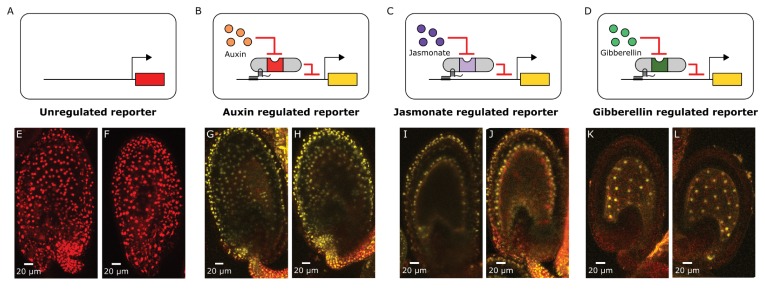
Distributions of auxin, gibberellin and jasmonate during early embryo development can be mapped out using HACRs.(A–D) These schematics depict the HACR circuits in the plant lines whose ovules have been imaged using confocal microscopy directly below them. (E–L) Confocal microscopy images of ovules from these reporter lines 48 hr post pollination visualizing either the tdTomato (in the case of the unregulated reporter) reporter signal or the Venus (in the case of the HACR lines) reporter signal. We observe ubiquitous reporter signal in the unregulated reporter (E,F) confirming that the UBQ1 promoter does not have differential expression across the ovule that could confound the observations from the HACR reporters. The auxin HACR reporter signal is present in the developing embryo, as reported previously. The JA HACR reporter signal is potentially localized to specific cell files (inner- and outer-layers) in the integument of the ovule (I,J). The GA HACR reporter signal is specifically localized to the endosperm, as we would expect based on the expression of GA biosynthesis genes (K,L).